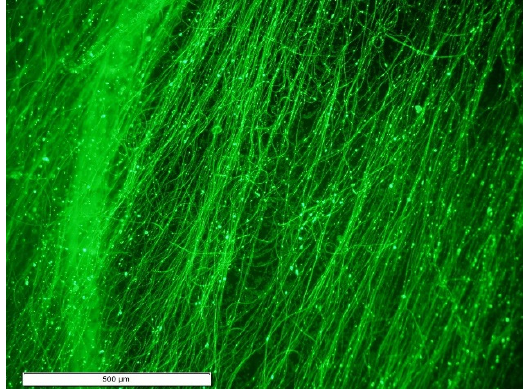
Figure 5. Anti-GSH antibody staining demonstrated the attachment of GSH to the PCL nanofibers. The value in the scale bar is 500 µm.